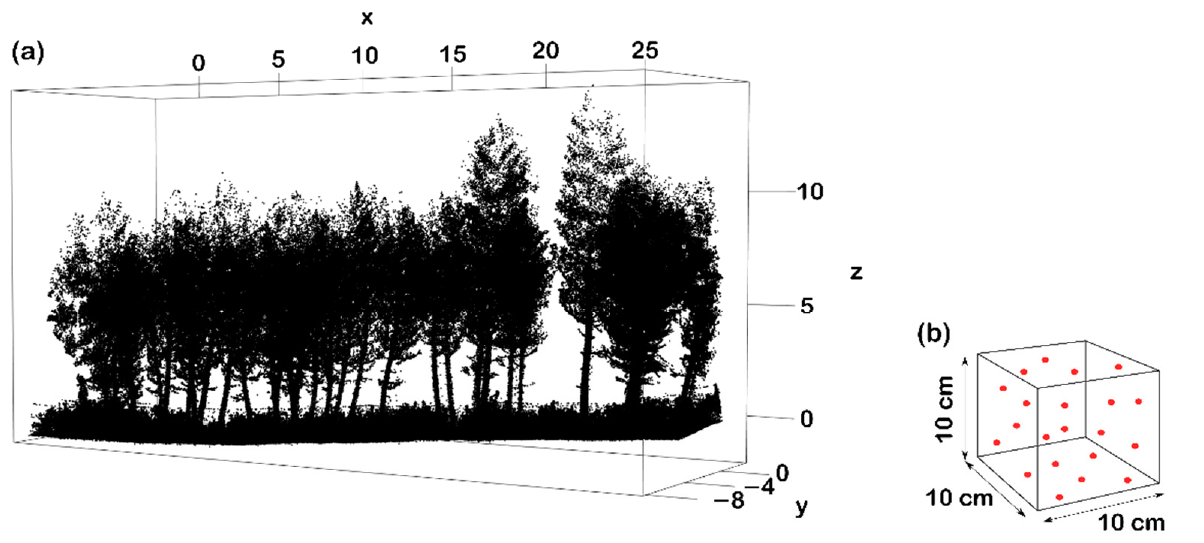
Figure 3. Point cloud acquired with GeosLAM. ( a ) Example of a clipped plot point cloud correspond- ing to plot 22. ( b ) Schematic example of voxelization.